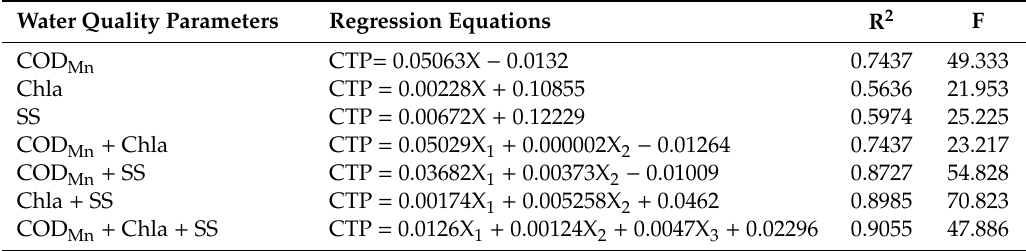
Table 4. Regression analysis of total phosphorus (TP) and other water quality parameters.